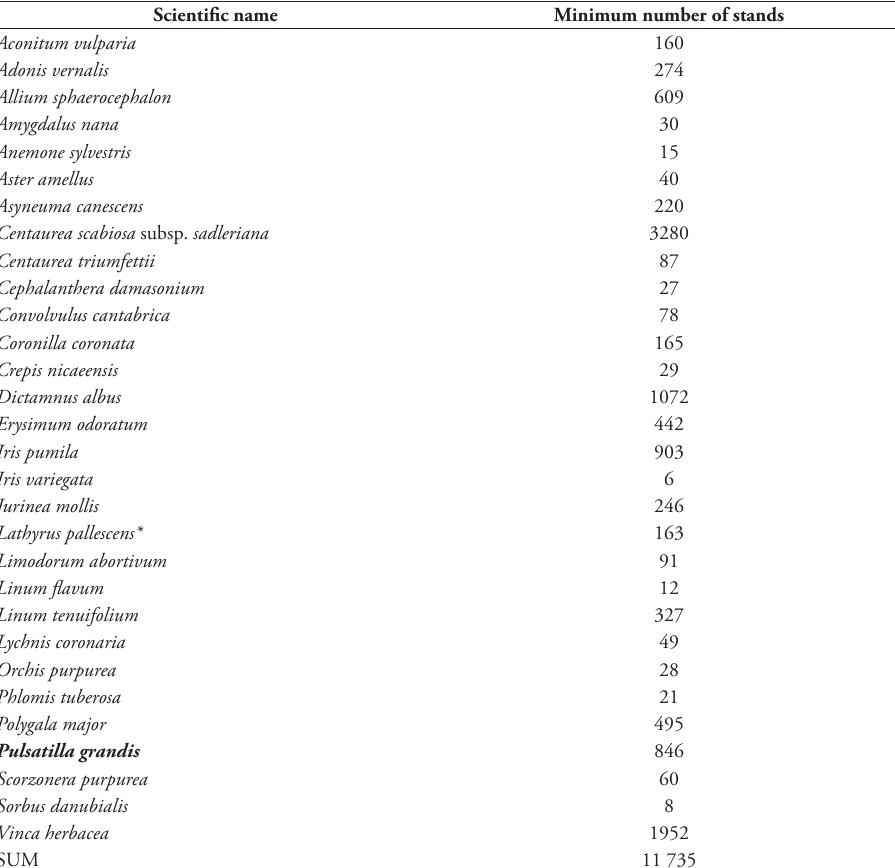
Table 1. Protected plant species found on the Széchenyi Hill, Budapest (strictly protected species is indi- cated with an asterisk; Natura 2000 Annex species in